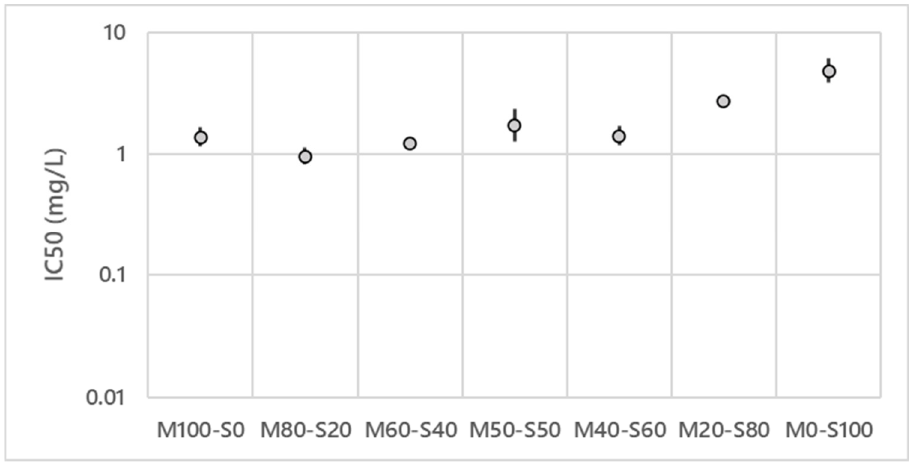
Figure 3. Effect of the lipopeptide ratios ( w / w ) on the IC 50 of mycosubtilin/surfactin mixtures on V. inaequalis S755 strain. Logarithmic